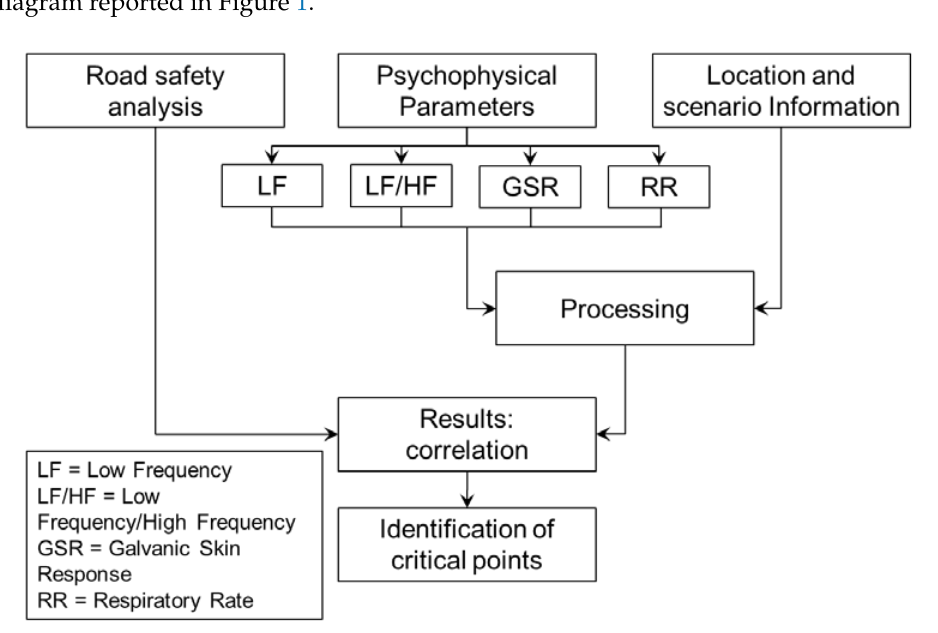
Figure 1. Procedural diagram of the study.